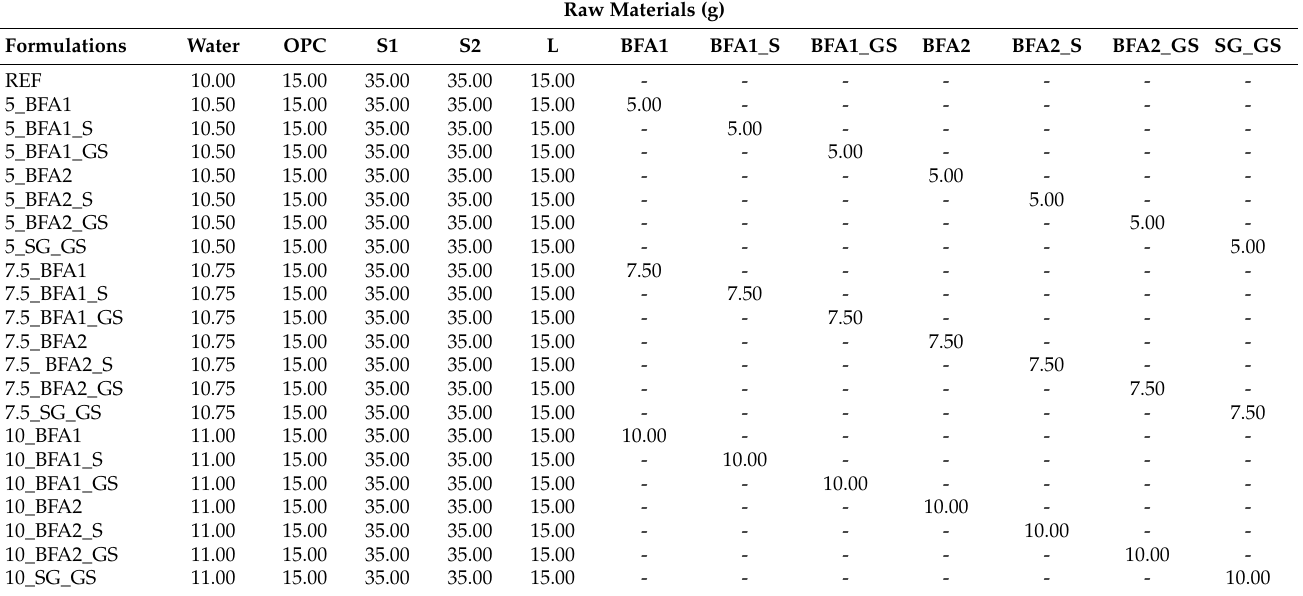
Table 6. Prepared